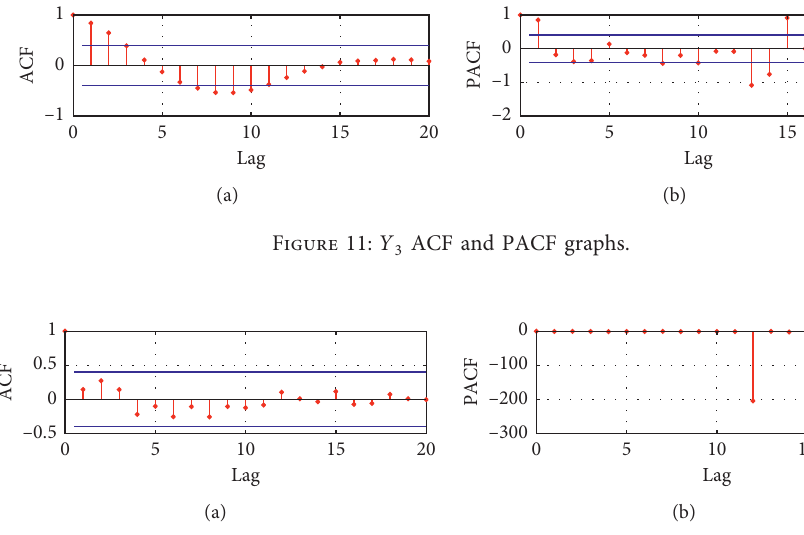
) , (b) “data2” without tendency ( Y 3